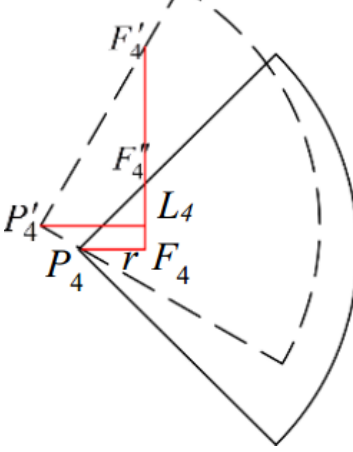
Figure 9. Two reachable area on the ground and enhanced stride F (cid:48)(cid:48) length ( F (cid:48) ) of leg 4 before and after the trunk twisting when 4 4 0 < P 4 F 4 < P 4 N . Where F 4 is the original foothold, F (cid:48) thest foothold after trunk twisting and F (cid:48) without trunk twisting.